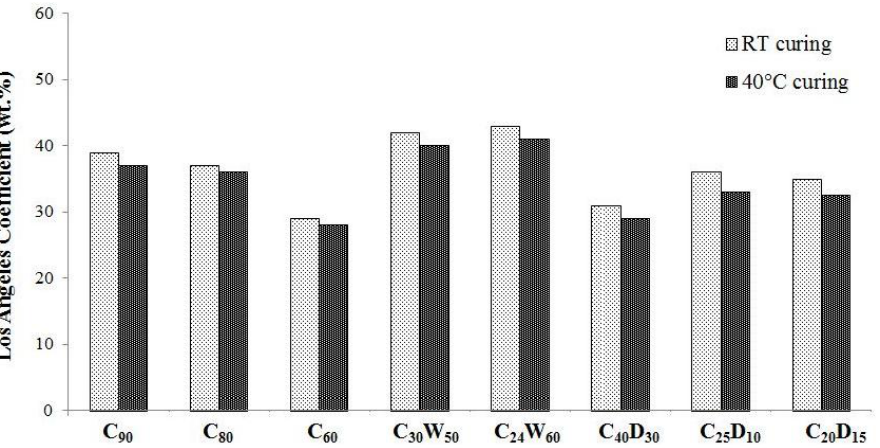
Figure 11. Los Angeles coefficient of artificial